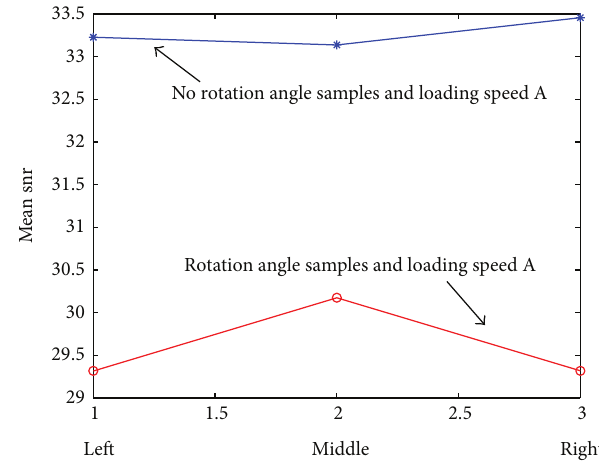
Figure 11: The mean snr of rotation and no rotation specimens under loading speed A.